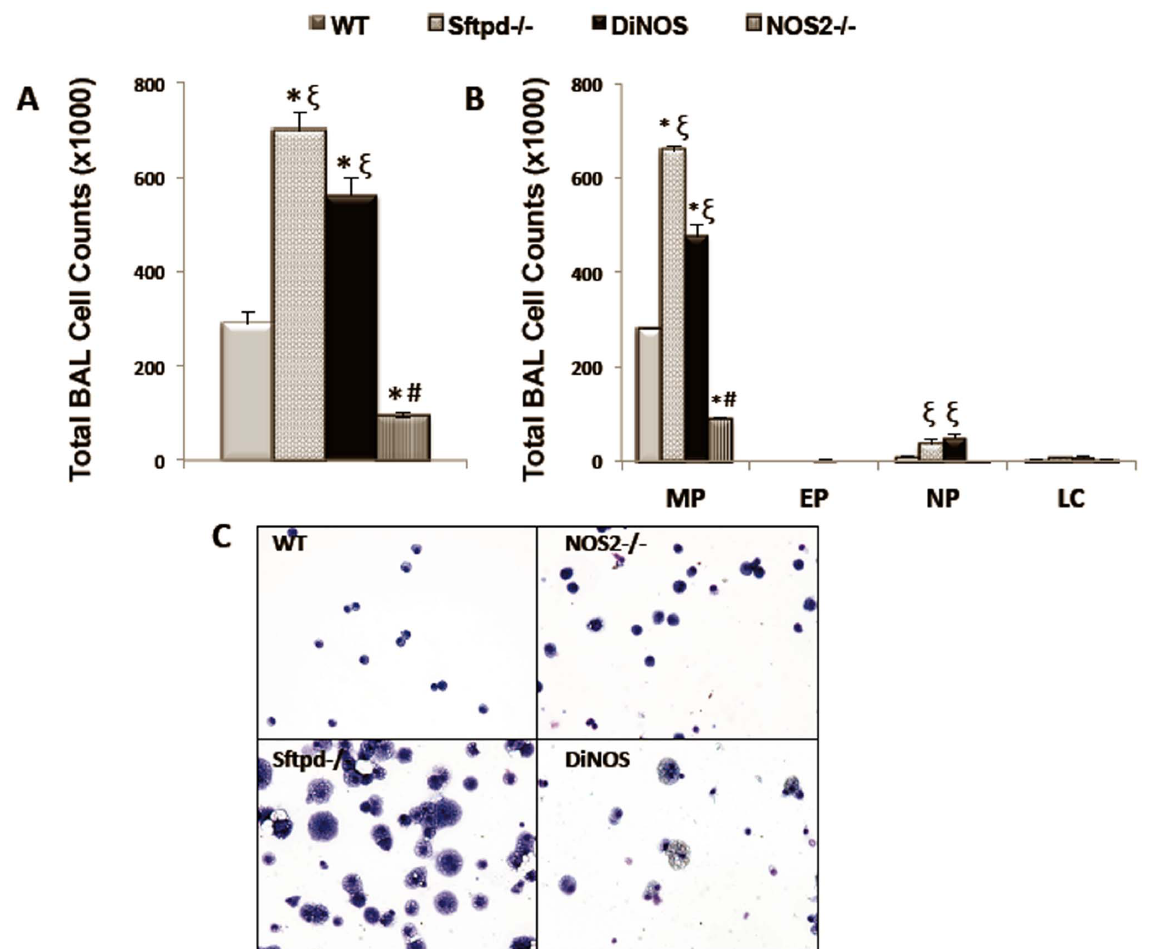
Figure 7. DiNOS mice exhibit partial normalization of BAL cell counts. Lungs were lavaged with 0.5-ml aliquots of sterile saline to a total of 5 ml. Recovered BALF samples were centrifuged (300 g for 10 min) and the cell pellet was gently resuspended in 1 ml of PBS (with Ca 2 + and Mg 2 + ). ( A ) Total cell count was determinated using a Z1 Counter particle counter (Beckman Coulter). ( B ) Aliquots of cells were spun on a Thermo Shandon Cytospin-3 at 750 rpm for 3 min and stained with standard Diff-Quik for manual determination of cell differentials. Cells were identified as macrophages, eosinophils, neutrophils, and lymphocytes by standard morphology. Data shown are mean 6 S.E., n=7 animals per genotype. Statistically significant differences between groups (p , 0.05) are indicated as: * vs WT; j vs NOS2 2 / 2 ; # vs Sftpd 2 / 2 mice. ( C ) Representative Diff-Quik staining of cytospins from WT and Sftpd 2 / 2 , DiNOS and NOS2 2 / 2 mice.